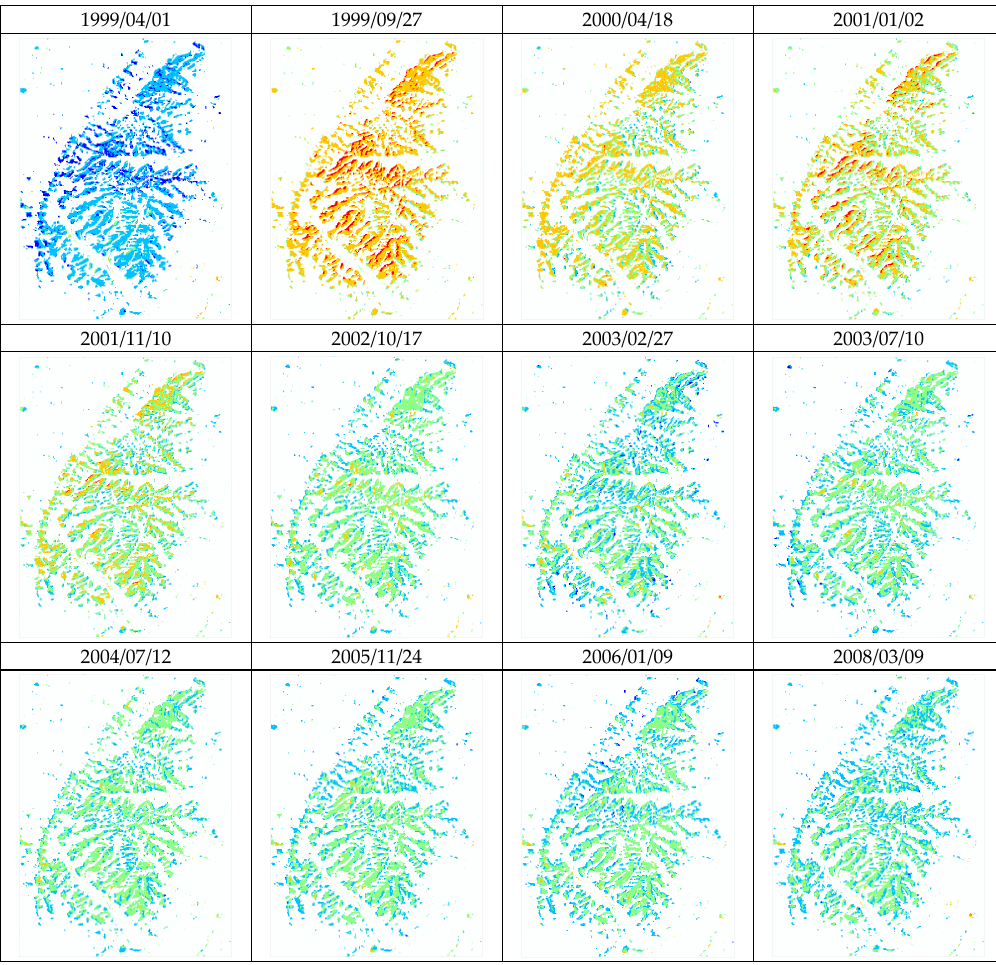
Figure 5. NDVI values of total, non-landslide, and landslide areas.